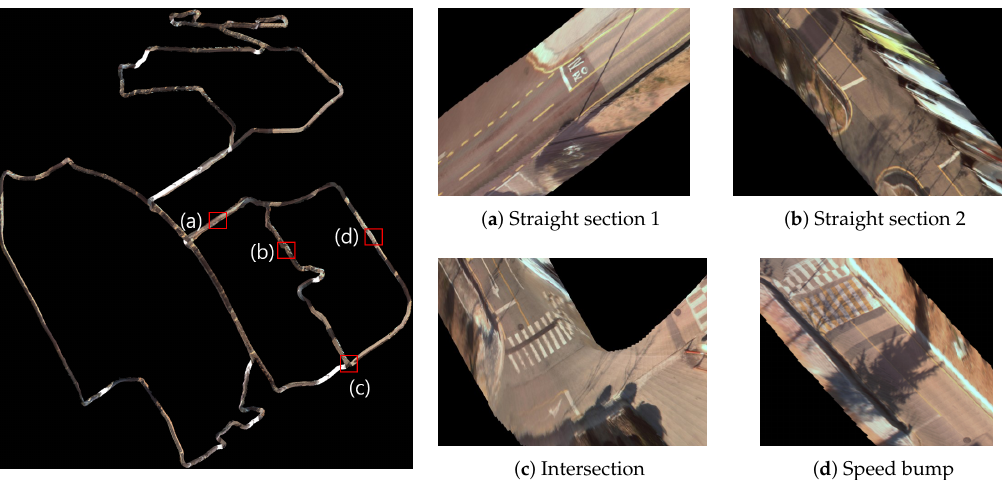
Figure 16. Generated lane map. ( a ) and ( b ) is a narrow straight section without and with parked car respectively. ( c ) is intersection and ( d ) includes speed bump and crosswalk.